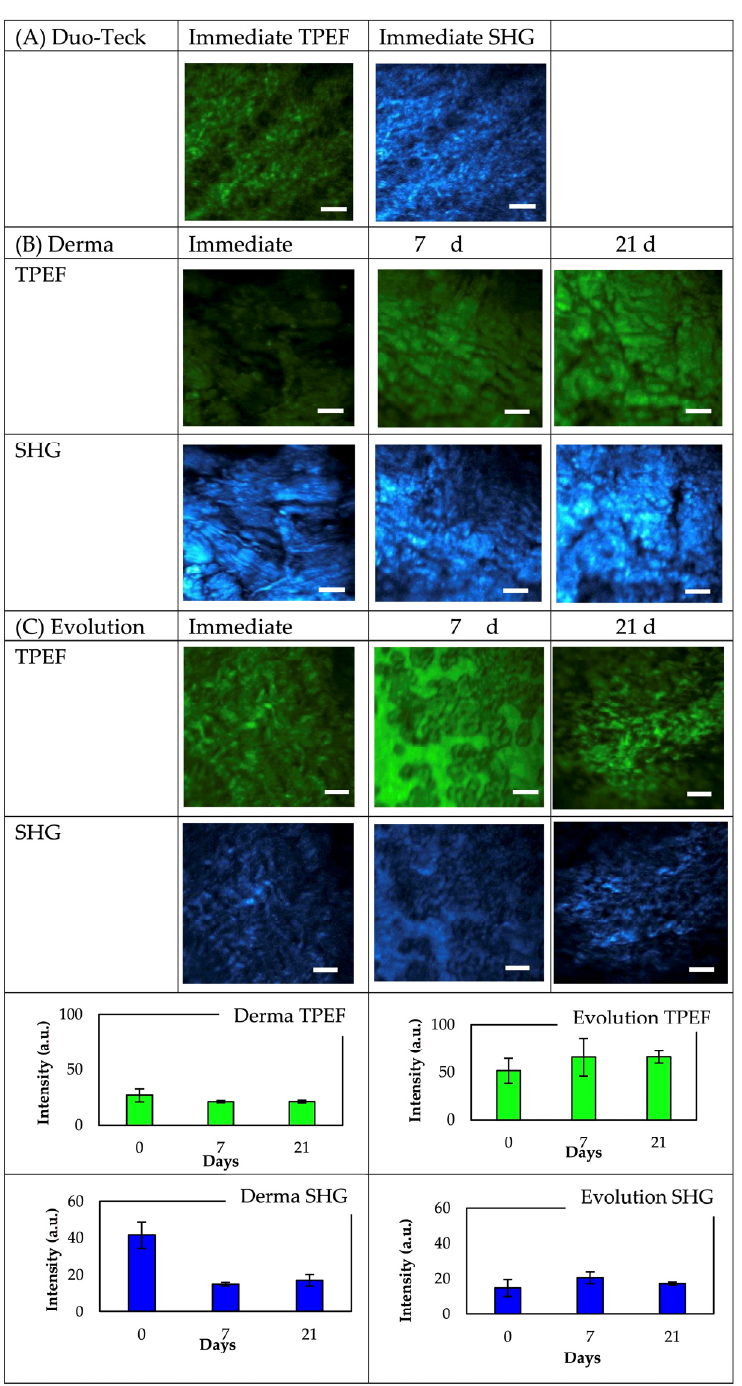
Figure 5. TPEF and SHG images of representative membranes. Scale bar: 25 µm.